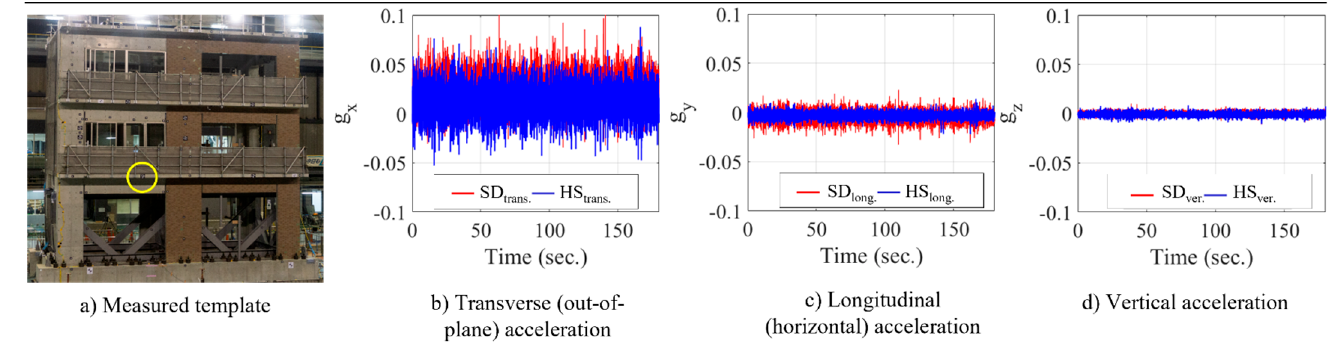
Figure 10. White noise response as measured by high-speed and commercial DSLR system measurements in three principal axes as measured from the marked template.